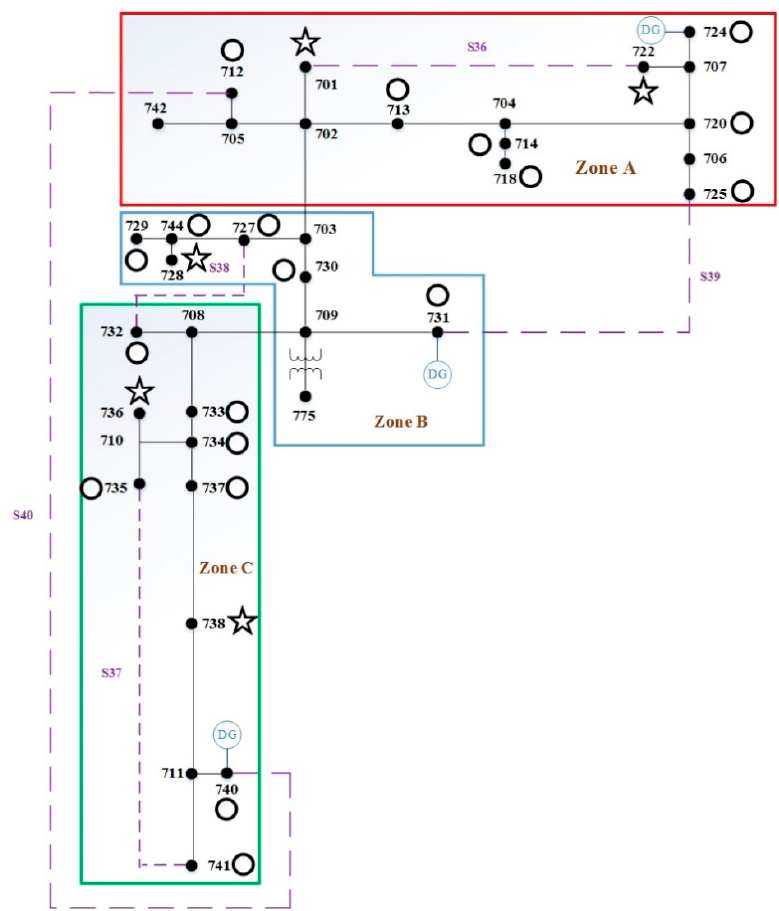
Figure 8. Single-line diagram of the sample system under islanding operation mode. Table 4. Simulation results under islanding operation mode.